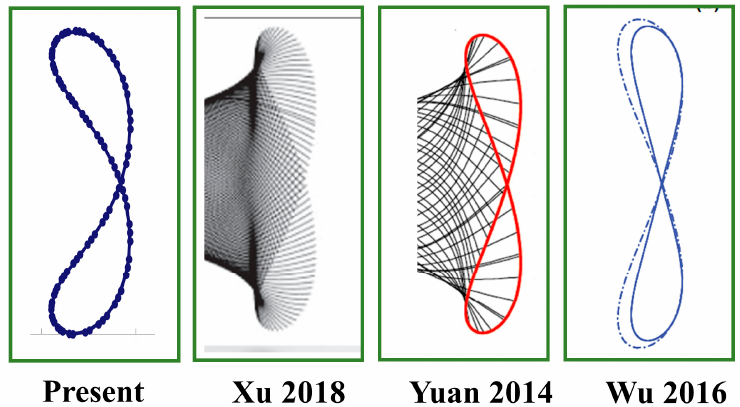
Figure 9. Comparison diagram of the tail movement trajectory of the flexible filament with three cases: Xu [46], Yuan [24] and Wu [20].